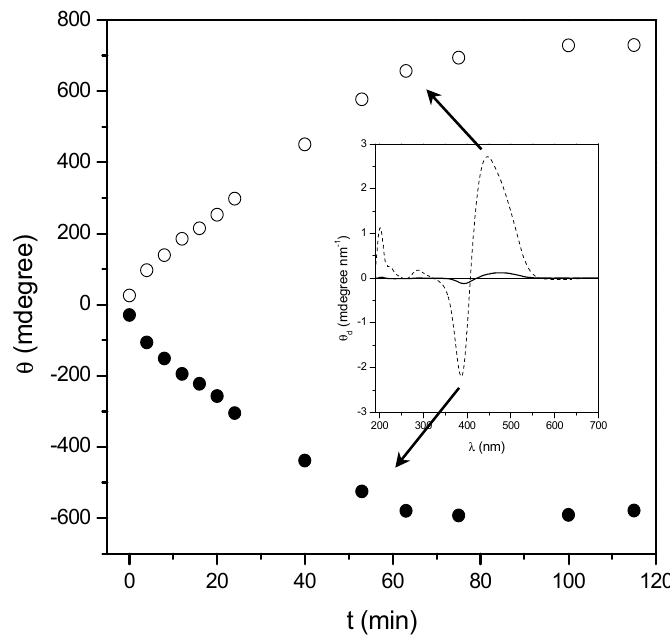
Figure 8. Evolution of the ellipticity at 440 ( ○ ) and 385 nm ( ● ) versus the annealing time relative to poly[( R )- MAP-C ] amorphous thin film heating at 200 °C.